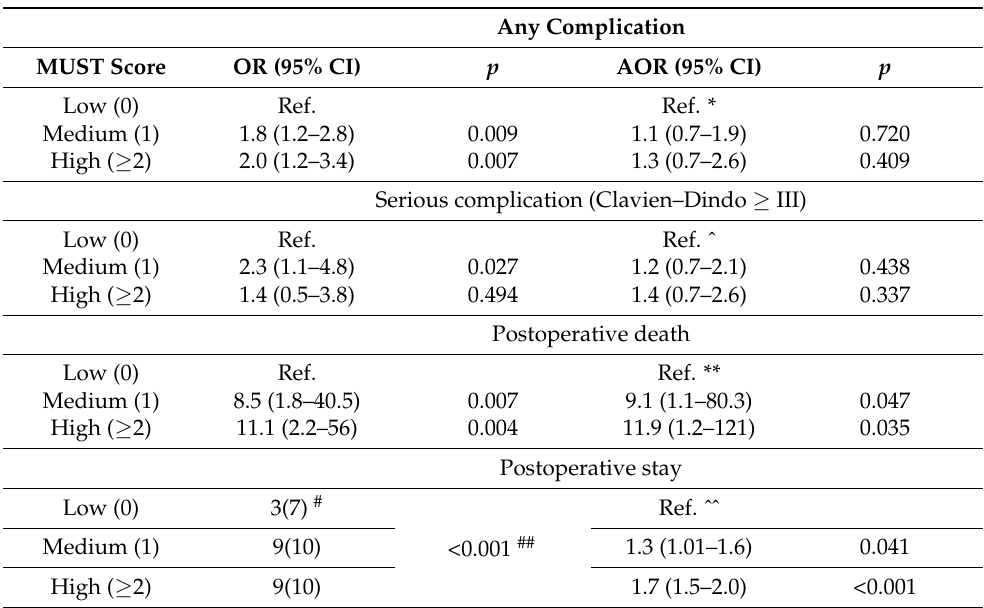
Table 4. Univariate analysis odds ratio (OR) and multiple regression analysis adjusted OR (AOR) for postoperative complications and postoperative length of